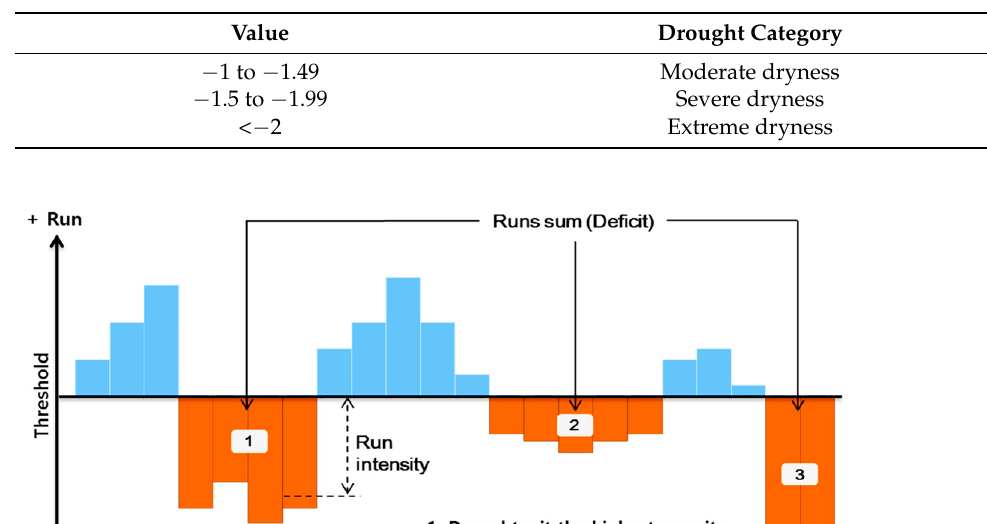
Table 2. Drought classification scheme [39].